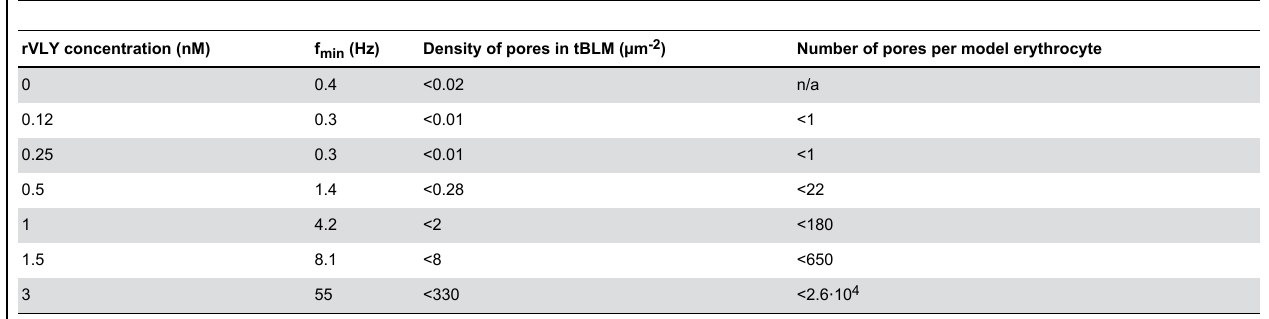
Table 2. Estimates of defect density and number of pores per model erythrocyte.